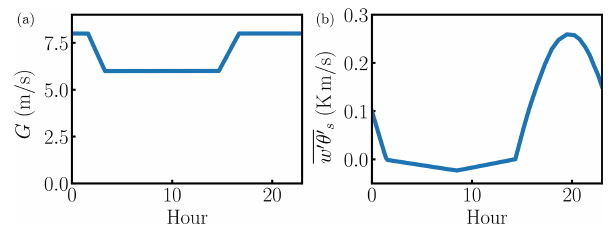
Figure D1. (a) Reference turbine wind direction for open-loop wake steering control cases for two differing parallel processor topologies. The simulations are executed from identical initial con- ditions. (b) The yaw misalignment set points implemented in the two open-loop lookup table control